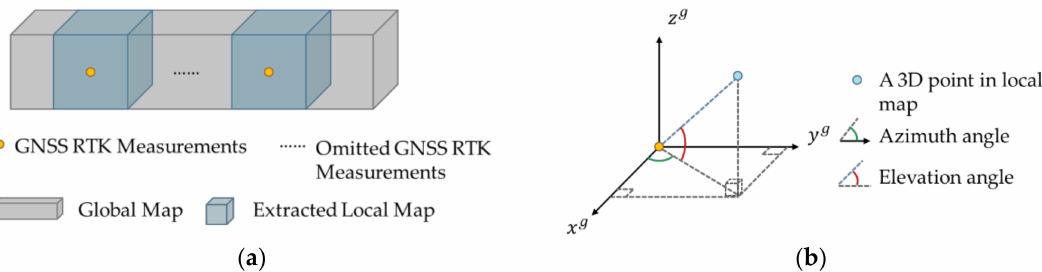
Figure 2. Illustration of the individual steps of GNSS-RTK availability assessment method. ( a ) The local map around each GNSS RTK solution is extracted from the global map; ( b ) For each 3D point in the local map, the azimuth angle and the elevation angle are calculated for subregions division and mean elevation angle mask generation. For ease of visualization, the map point is depicted in the GNSS measurement